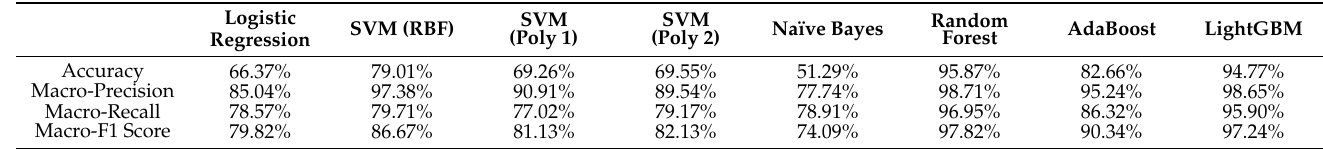
Table 5. Performance of each multilabel model to detect evasion and